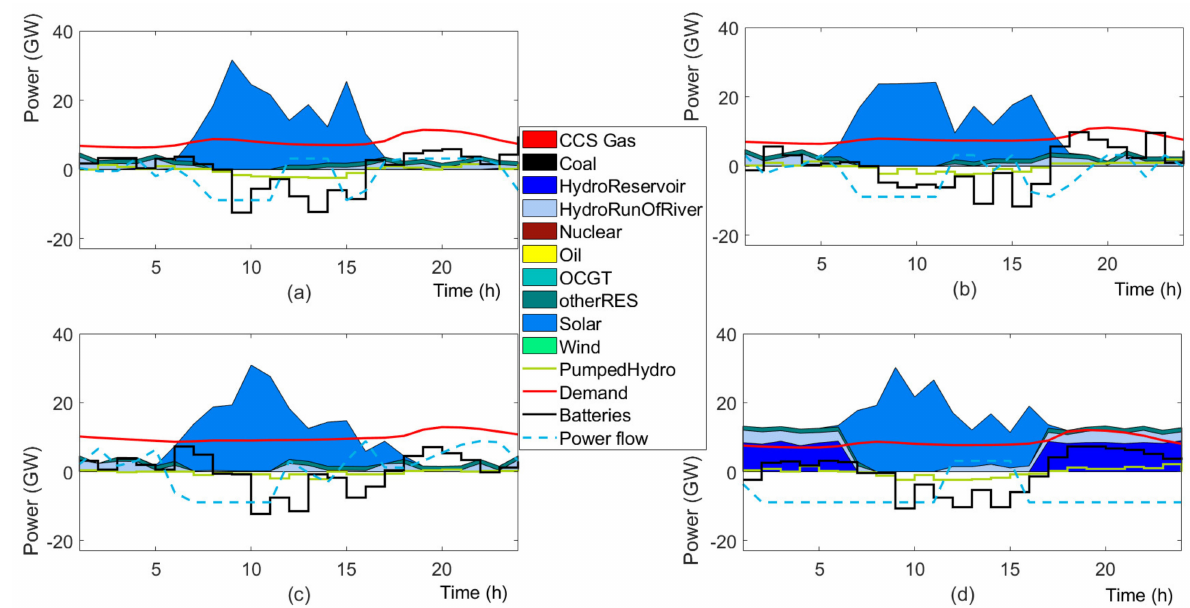
Figure 16. Generation mix in region NER according to scenario node 8 with the availability of storage, in four typical days. Figure ( a ) reports a typical day within the period January–March, ( b ) a typical day within April–June, ( c ) a typical day within July–September, and ( d ) a typical day within October–December.